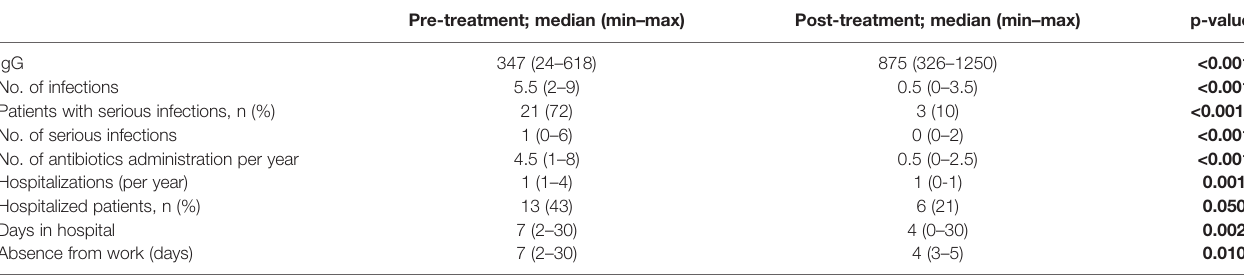
Pre-treatment; median (min – max)